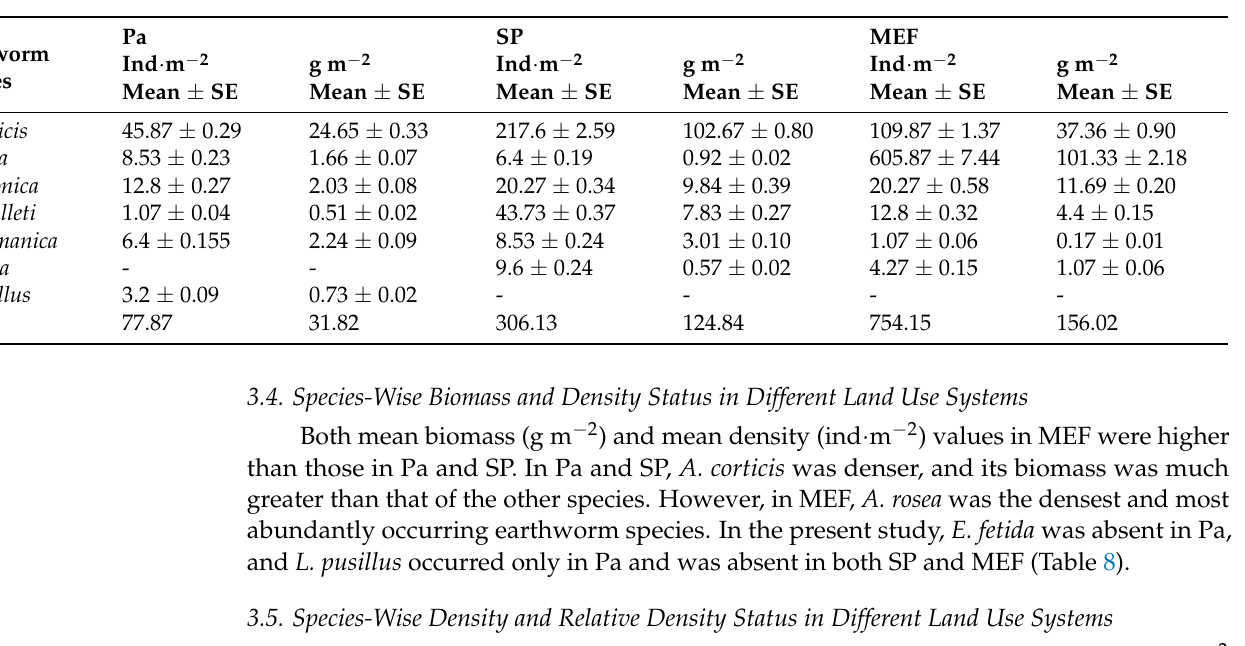
Table 8. Biomass (g m − 2 ) and density (ind · m − 2 ) of different earthworm species in different land use types.